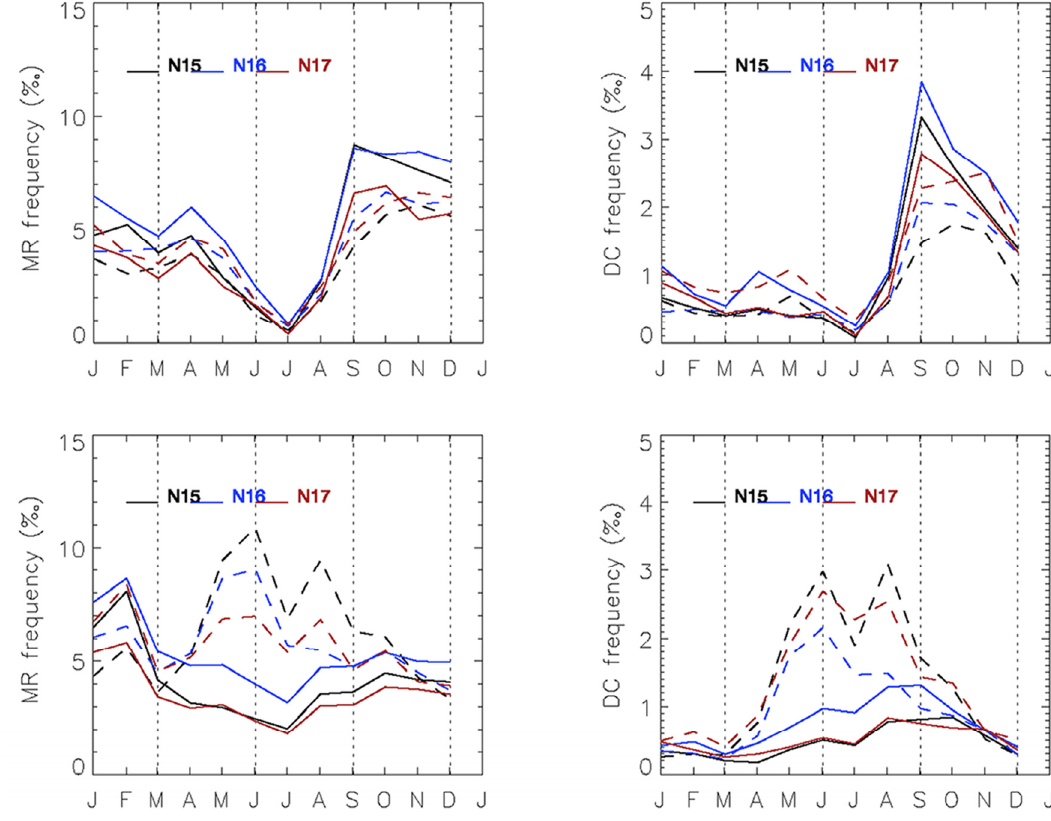
Figure 2. Descending (solid) and ascending (dashed) annual cycle of ( left column) moderate rain (MR) and ( right column) deep convection (DC) frequency for the Mediterranean Sea ( upper panel) and for land-only of the Mediterranean region ( lower panel) based on NOAA-15 (black), NOAA-16 (blue) and NOAA-17 (red) observations over